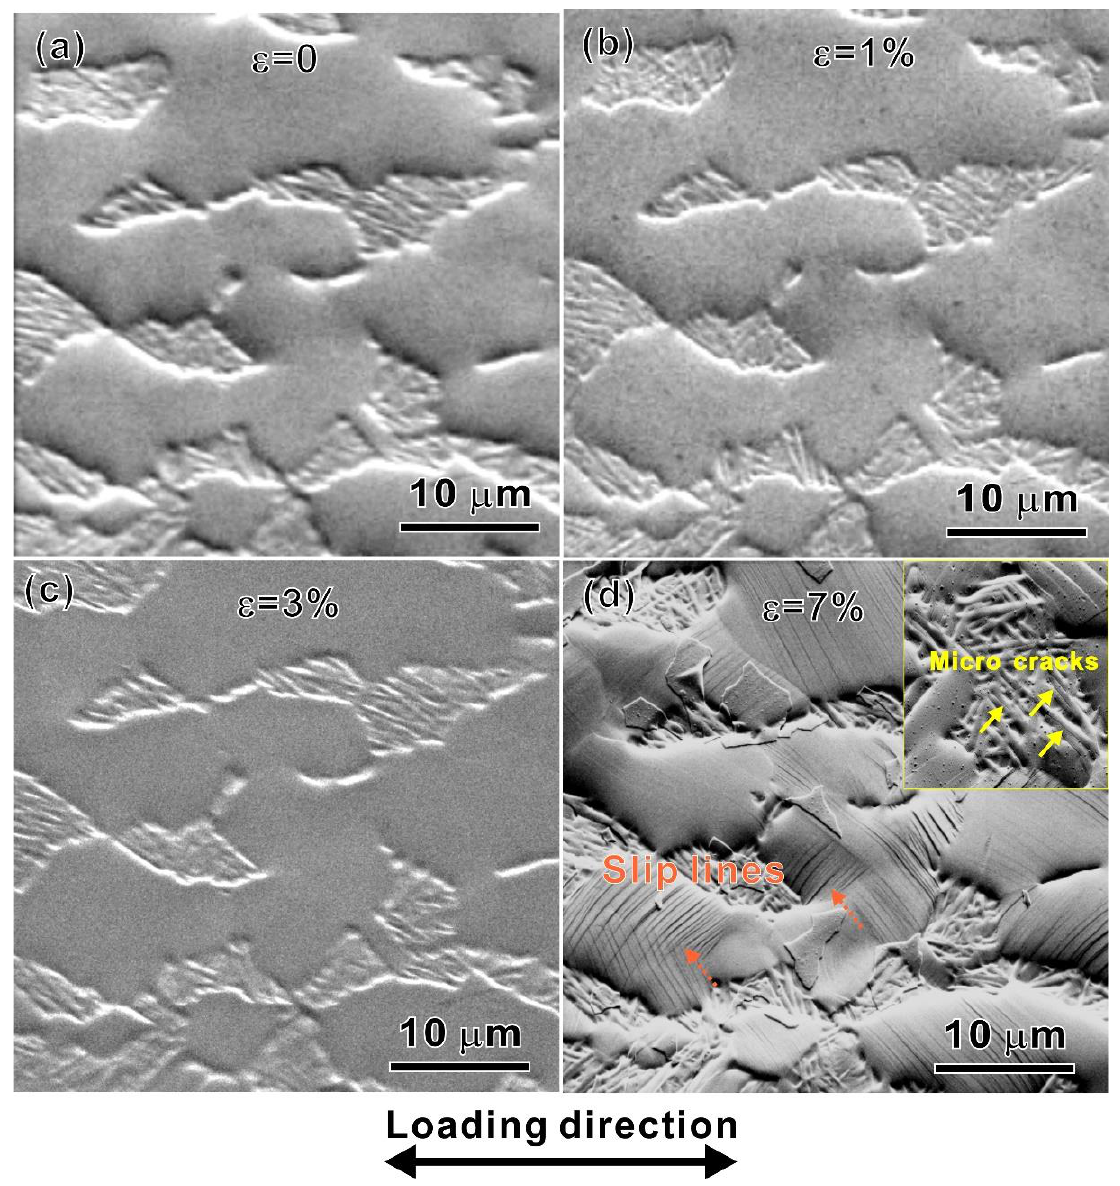
Figure 10. SEM images at the observation area with strains of ( a ) 0%; ( b ) 1%; ( c ) 3%; and ( d ) 7%, respectively.